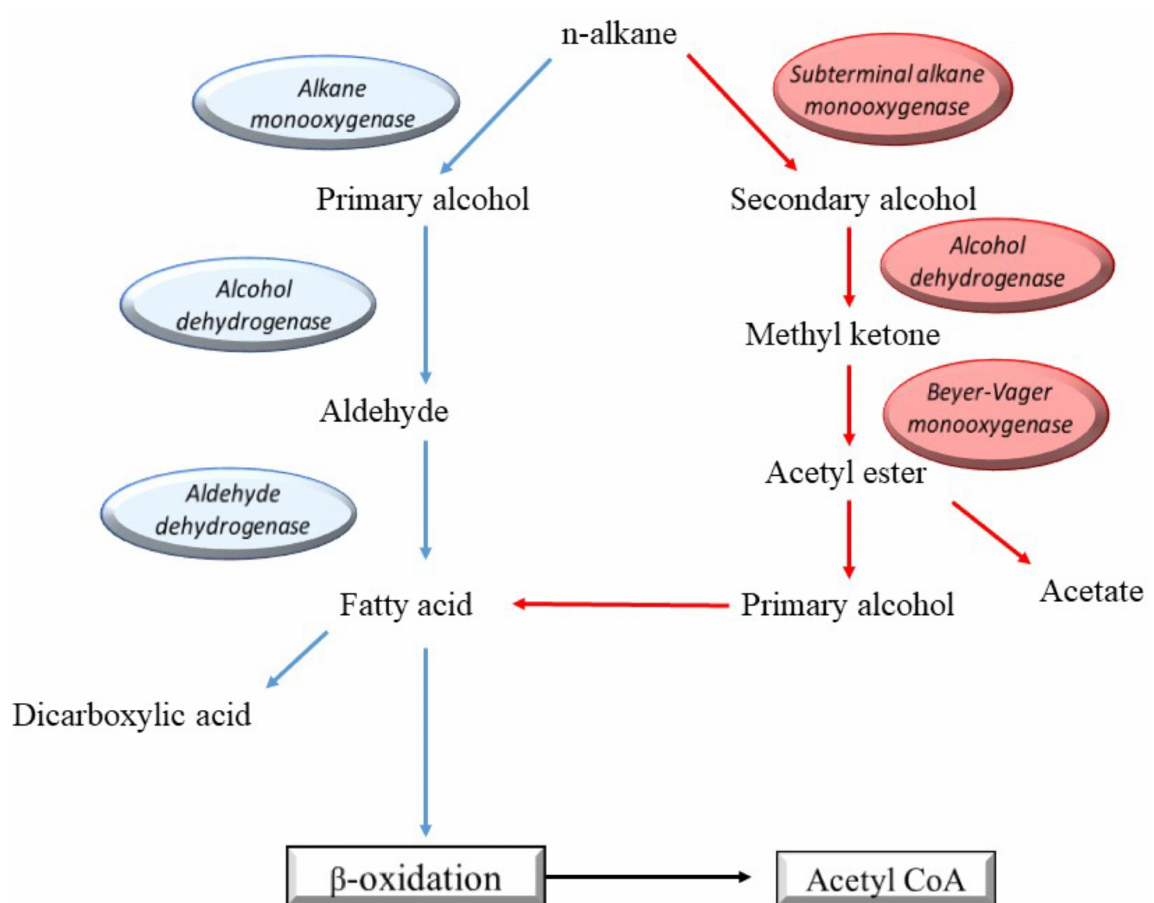
Figure 4. General microbial peripheral pathways of alkane degradation (adapted from